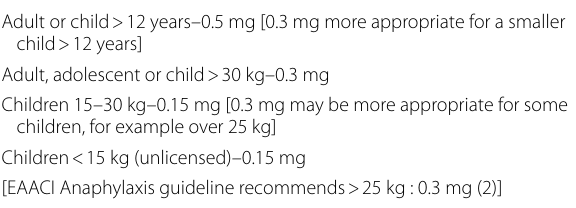
Table 1 Recommended doses of adrenaline available for self‑administration [1]